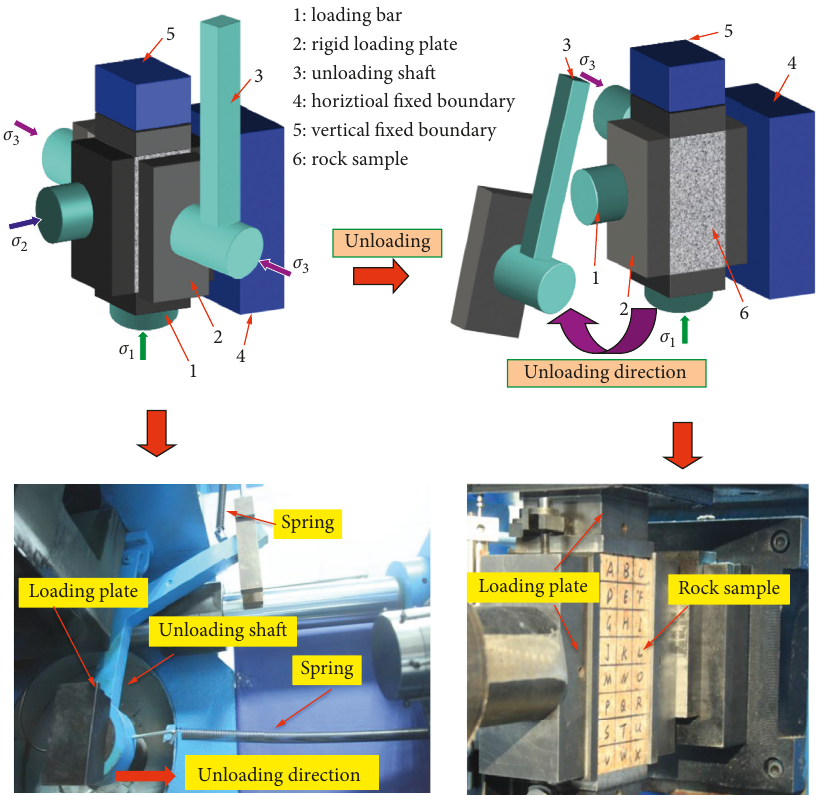
Figure 4: The unloading device of the test